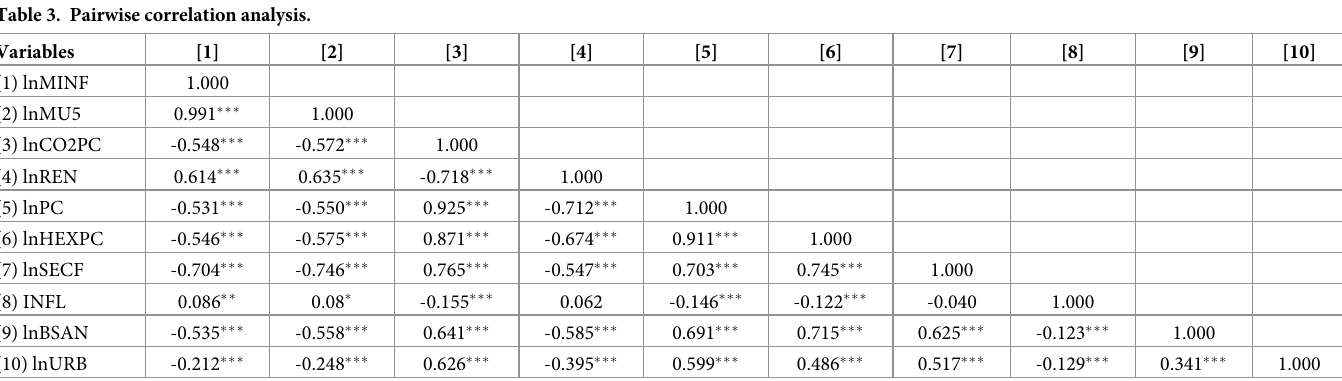
Table 3. Pairwise correlation